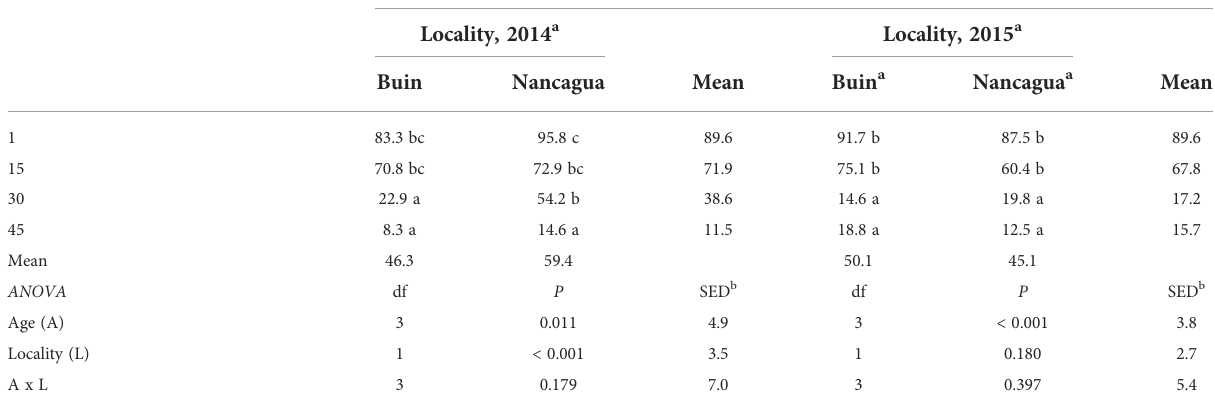
TABLE 3 Percent of pruning wound infected (%) by arti fi cial inoculation of Phaeomoniella chlamydospora at different ages of pruning wounds (1, 15, 30, and 45 days after pruning) in commercial vineyards cv. Cabernet Sauvignon during eight months in two localities (Buin and Nancagua), Central